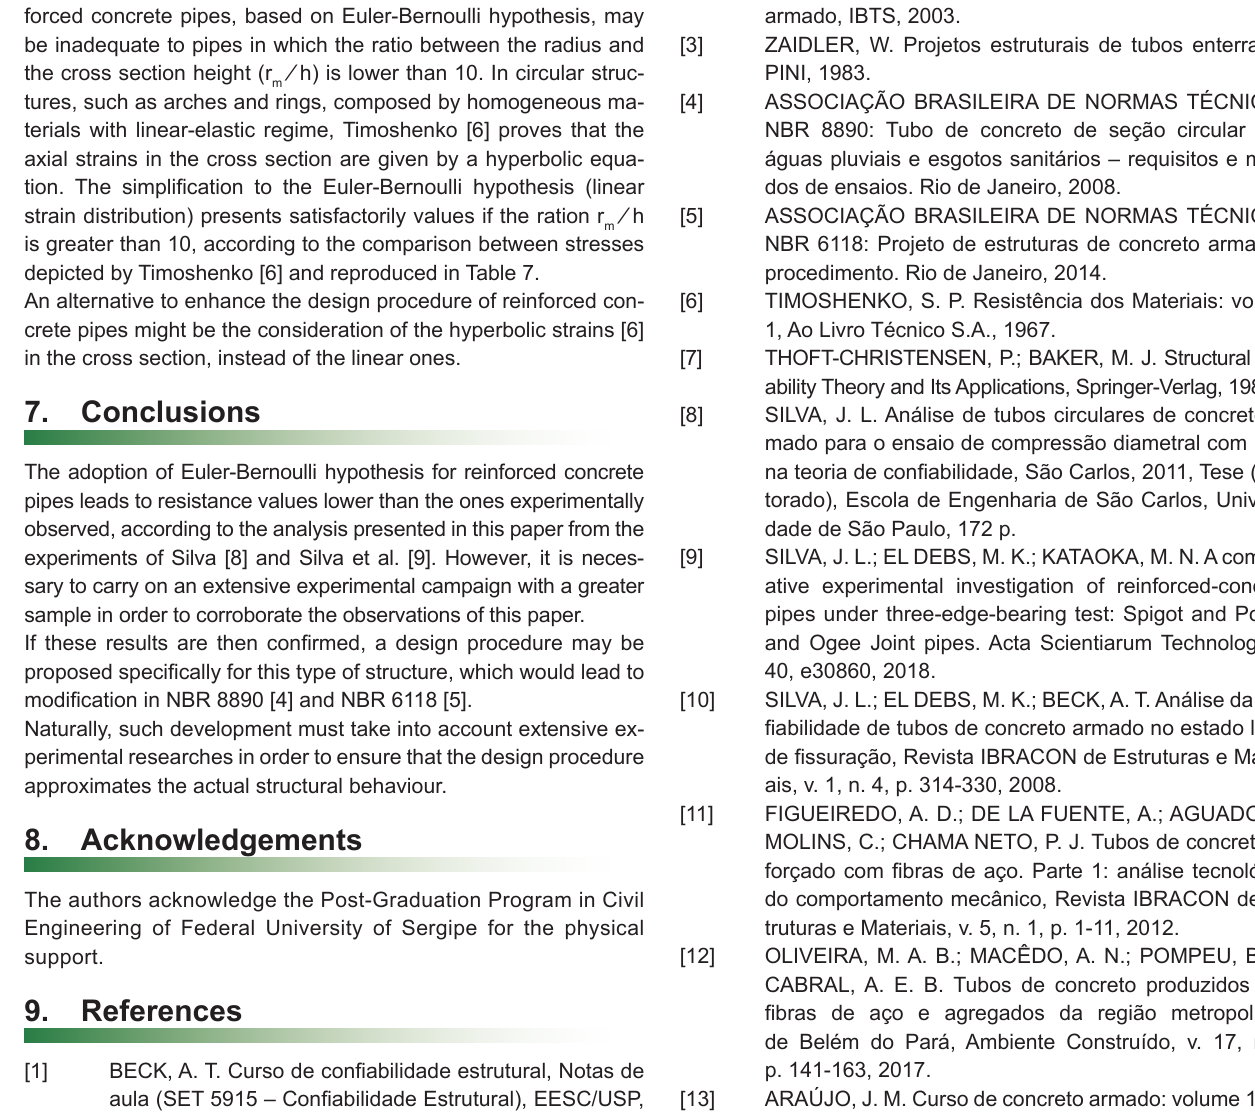
Table 7 Comparison of the hyperbolic and linear stress distributions [6] Hyperbolic stress distribution Linear stress distribution